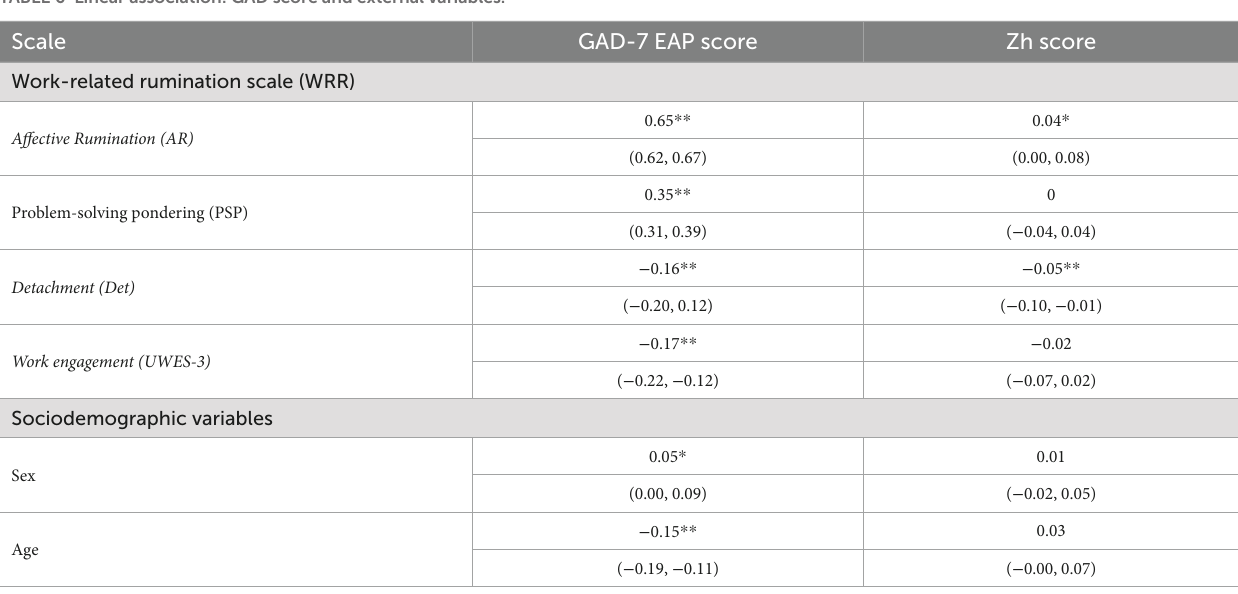
TABLE 6 Linear association: GAD score and external variables. Scale GAD-7 EAP score Zh score